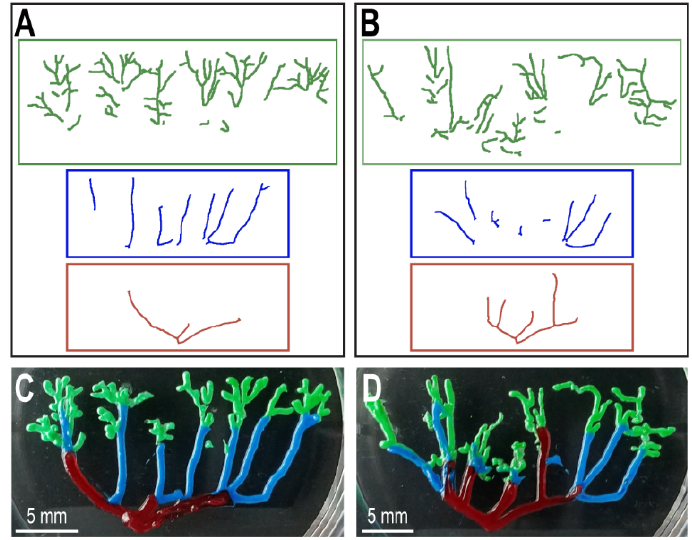
Figure 2. Conversion of mesenteric vascular branches into printable objects. The individual classes were separated and converted in printable arterial ( A ) and venous ( B ) .stl files, and direct ‐ write printed with the colored bioink surrogate (( C ) and ( D ), respectively). Bars: 5 mm.